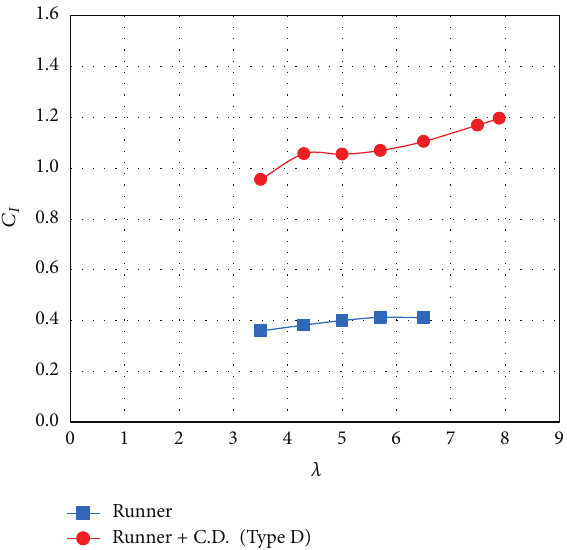
Figure 12: Correlation between the tip speed ratio and the input power coefficient.